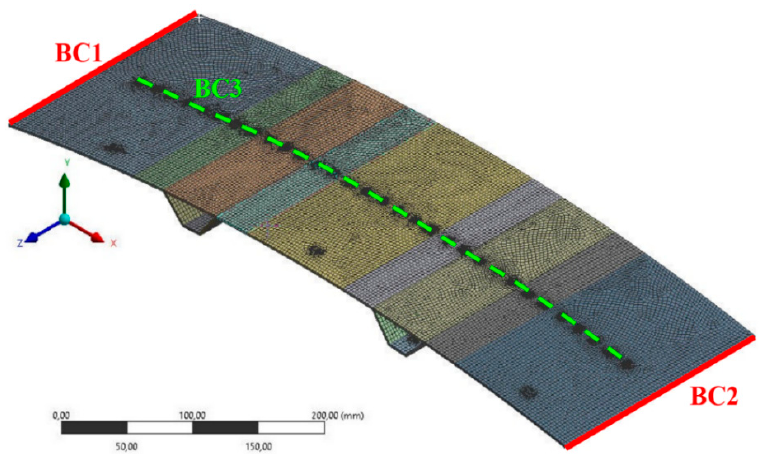
Figure 5. Mesh and boundary conditions of the finite element model of the omega-stiffened composite panel.